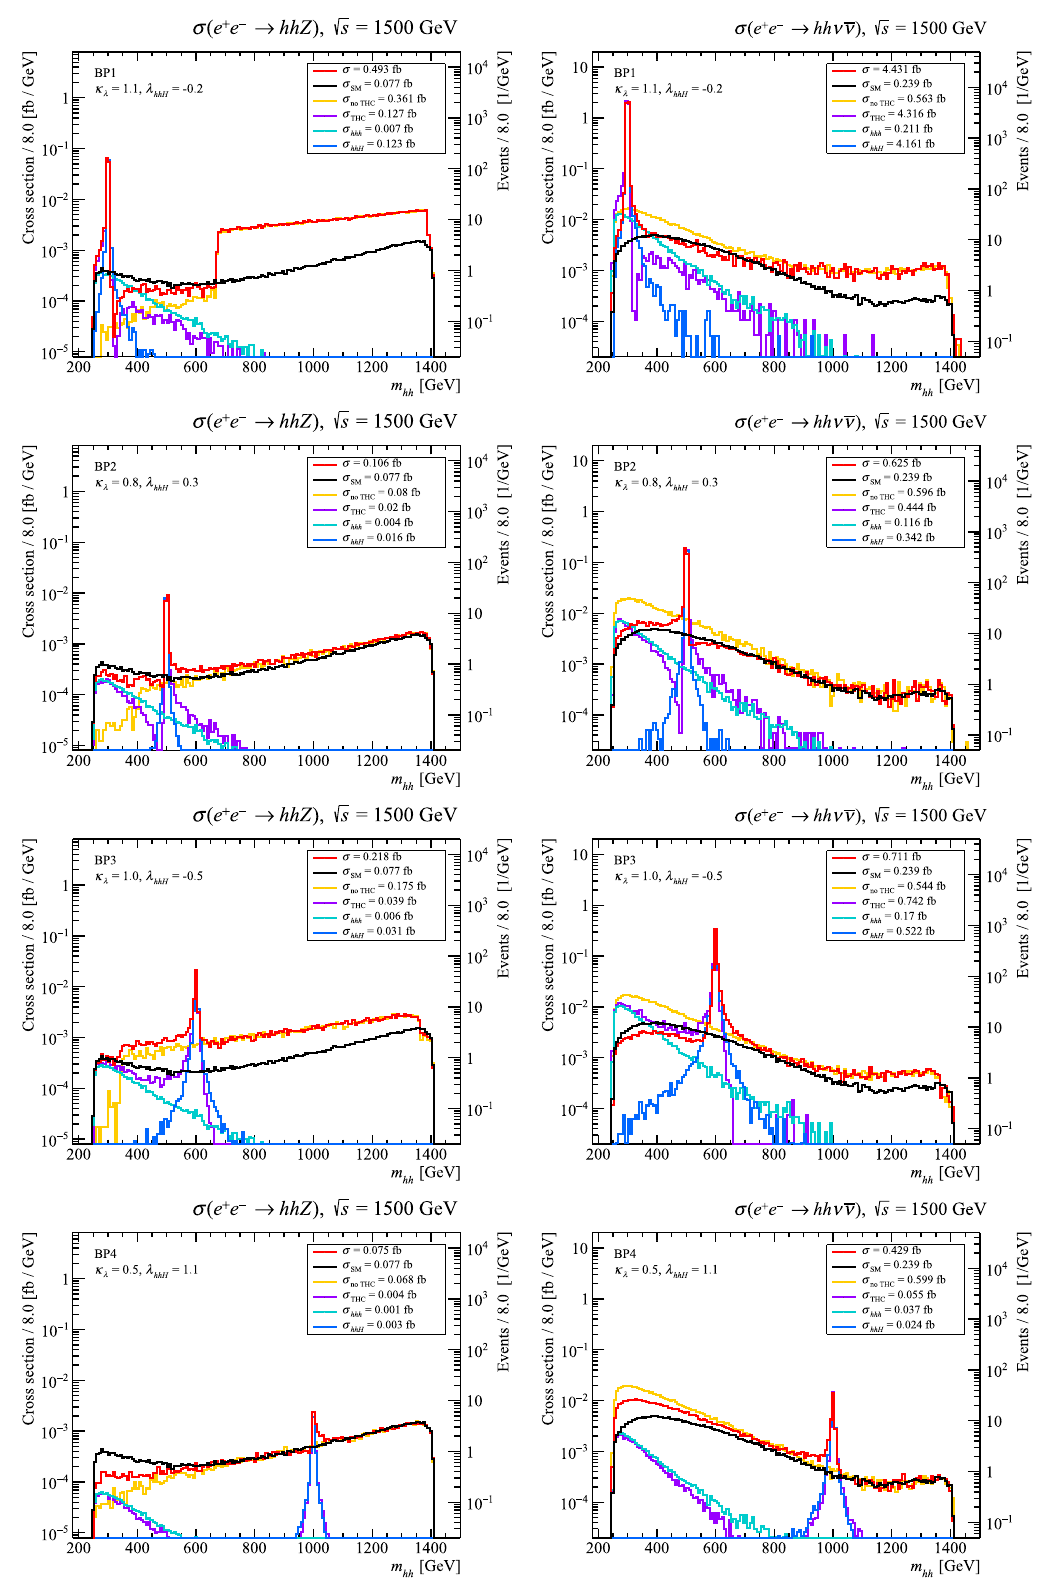
Fig. 22 Distribution on the invariant mass of the final hh pair in the process e + e − → hhZ (left) and e + e − → hh ν ¯ ν (right) at for BP1, BP2, BP3 and